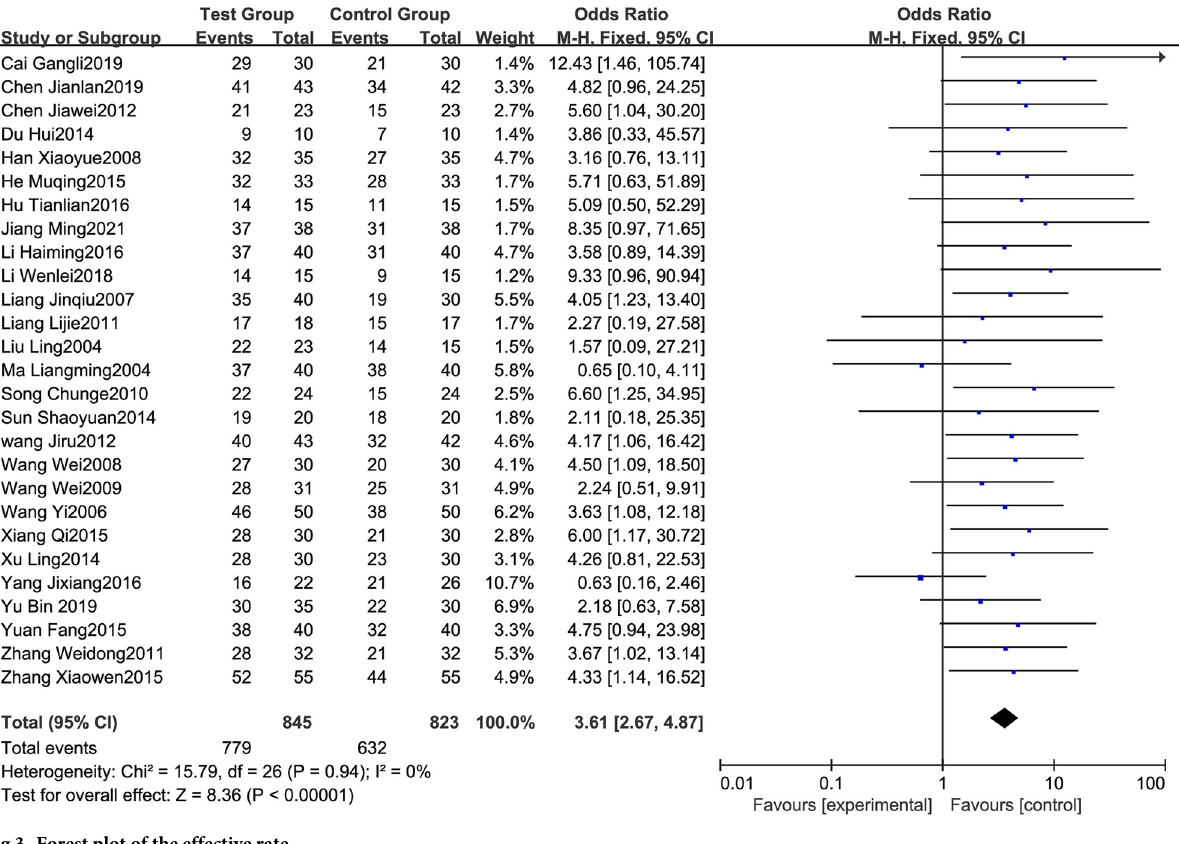
PLOS ONE | https://doi.org/10.1371/journal.pone.0275122 September 30,